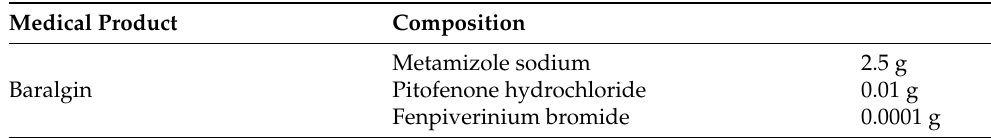
Table 3. Active ingredients in a 5 ml baralgin ampoule.